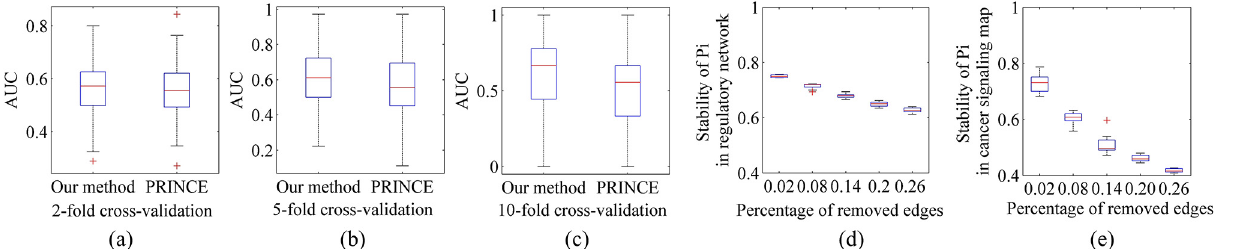
Fig 4. Analysis results for robustness of our method. (a) The AUC of 2-fold cross validation for prioritization of oncogenes in the cancer signaling map. (b) The AUC of 5-fold cross validation for prioritization of oncogenes in the cancer signaling map. (c) The AUC of 10-fold cross validation for prioritization of oncogenes in the cancer signaling map. (d) The stability of perturbation influence of the regulatory network. (e) The stability of perturbation influence of the cancer signaling map.